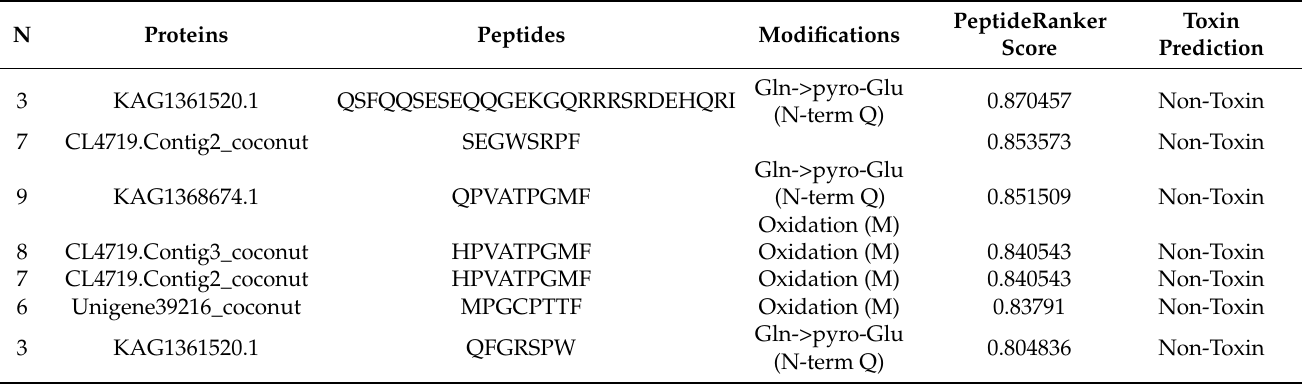
Table 3. Selected potential bioactive peptides of the globulin predicted by in-silico digestions with